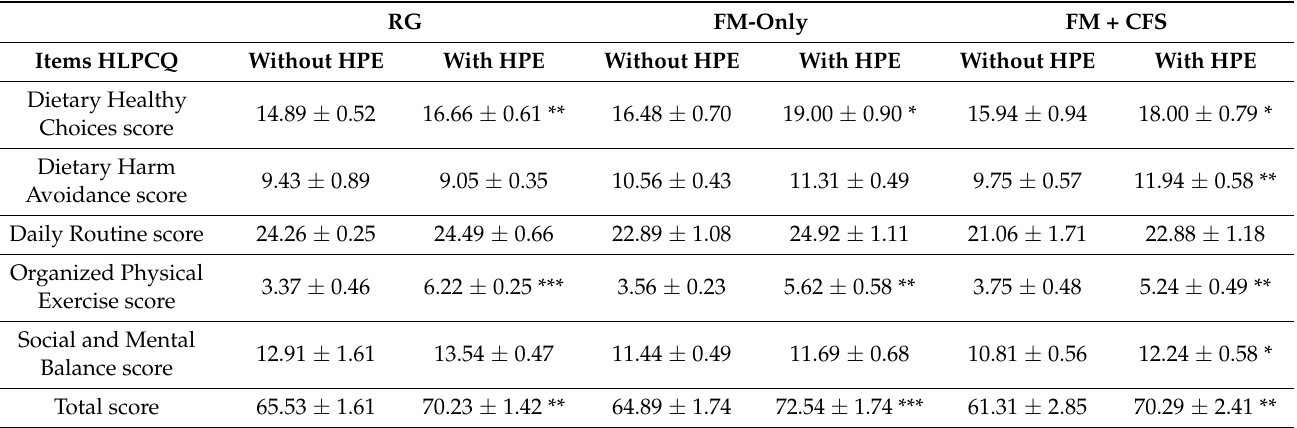
Table 3. Influence of habitual physical exercise (HPE) on the values of the HLPCQ items questionnaire in patients with FM, with and without associated